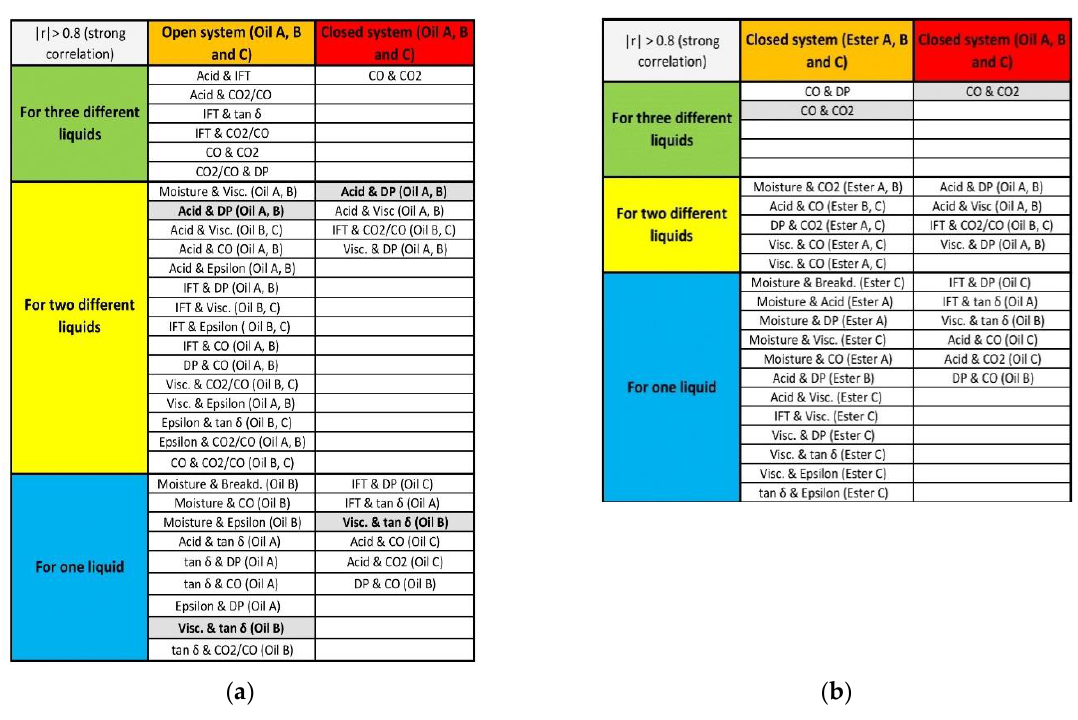
Figure 17. Comparison of the systems for a Pearson correlation coefficient | r | ≥ 0.8: ( a ) Comparison of the oils in the open and closed system; ( b ) Comparison of the oils and esters in the closed system.